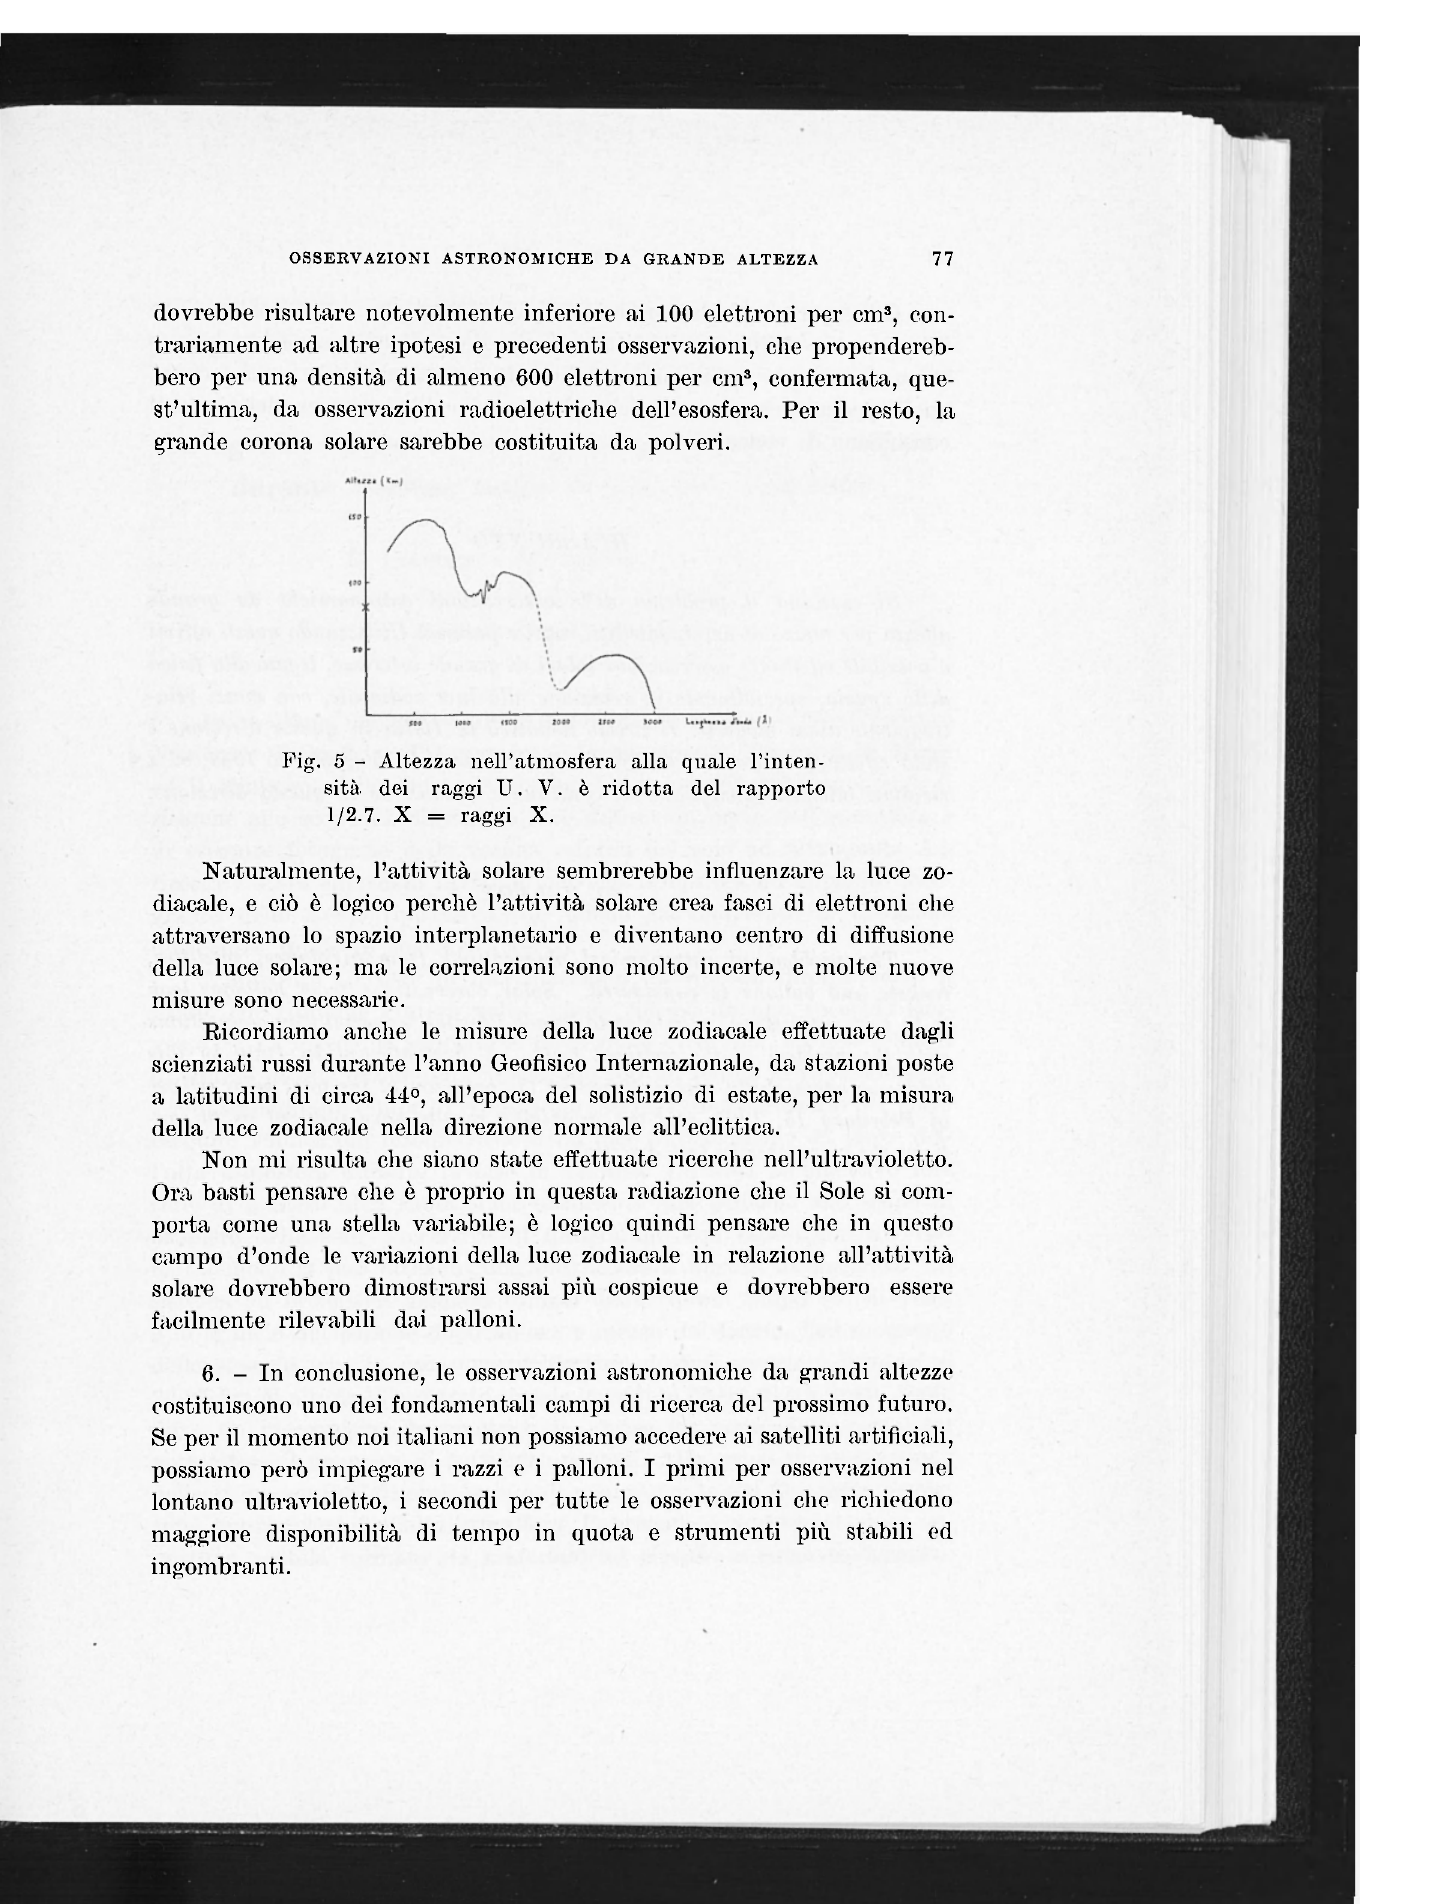
Fig. 5 - Altezza nell'atmosfera alla quale l'inten- sità, dei raggi U. V. è ridotta del rapporto 1/2.7. X = raggi